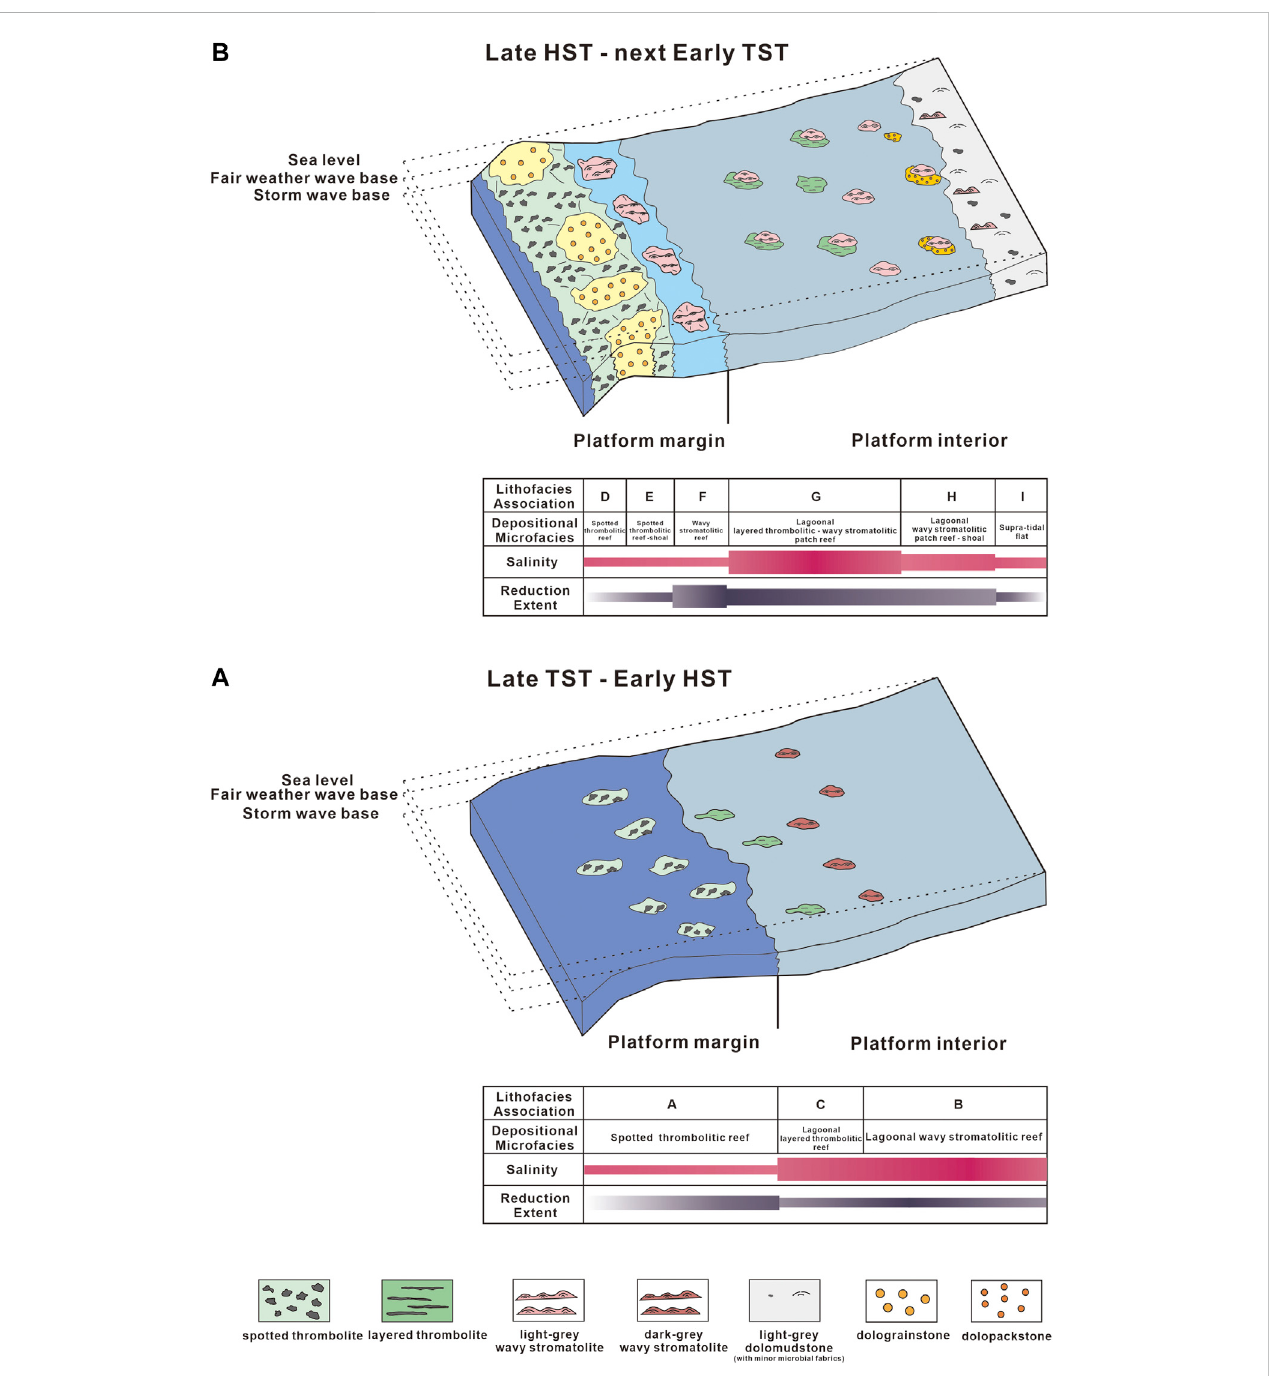
FIGURE 12 Depositional-paleo-environmental model of the microbialites of Z 2 dn 4 in a fourth-order sequence stratigraphic framework of the Gaoshiti — Moxi area. (A) Depositional-paleo-environmental evolution model of the microbialites during late fourth-order TST-early fourth-order HST. (B) Depositional-paleo- environmental model of the microbialites during late fourth-order HST-next early fourth-order